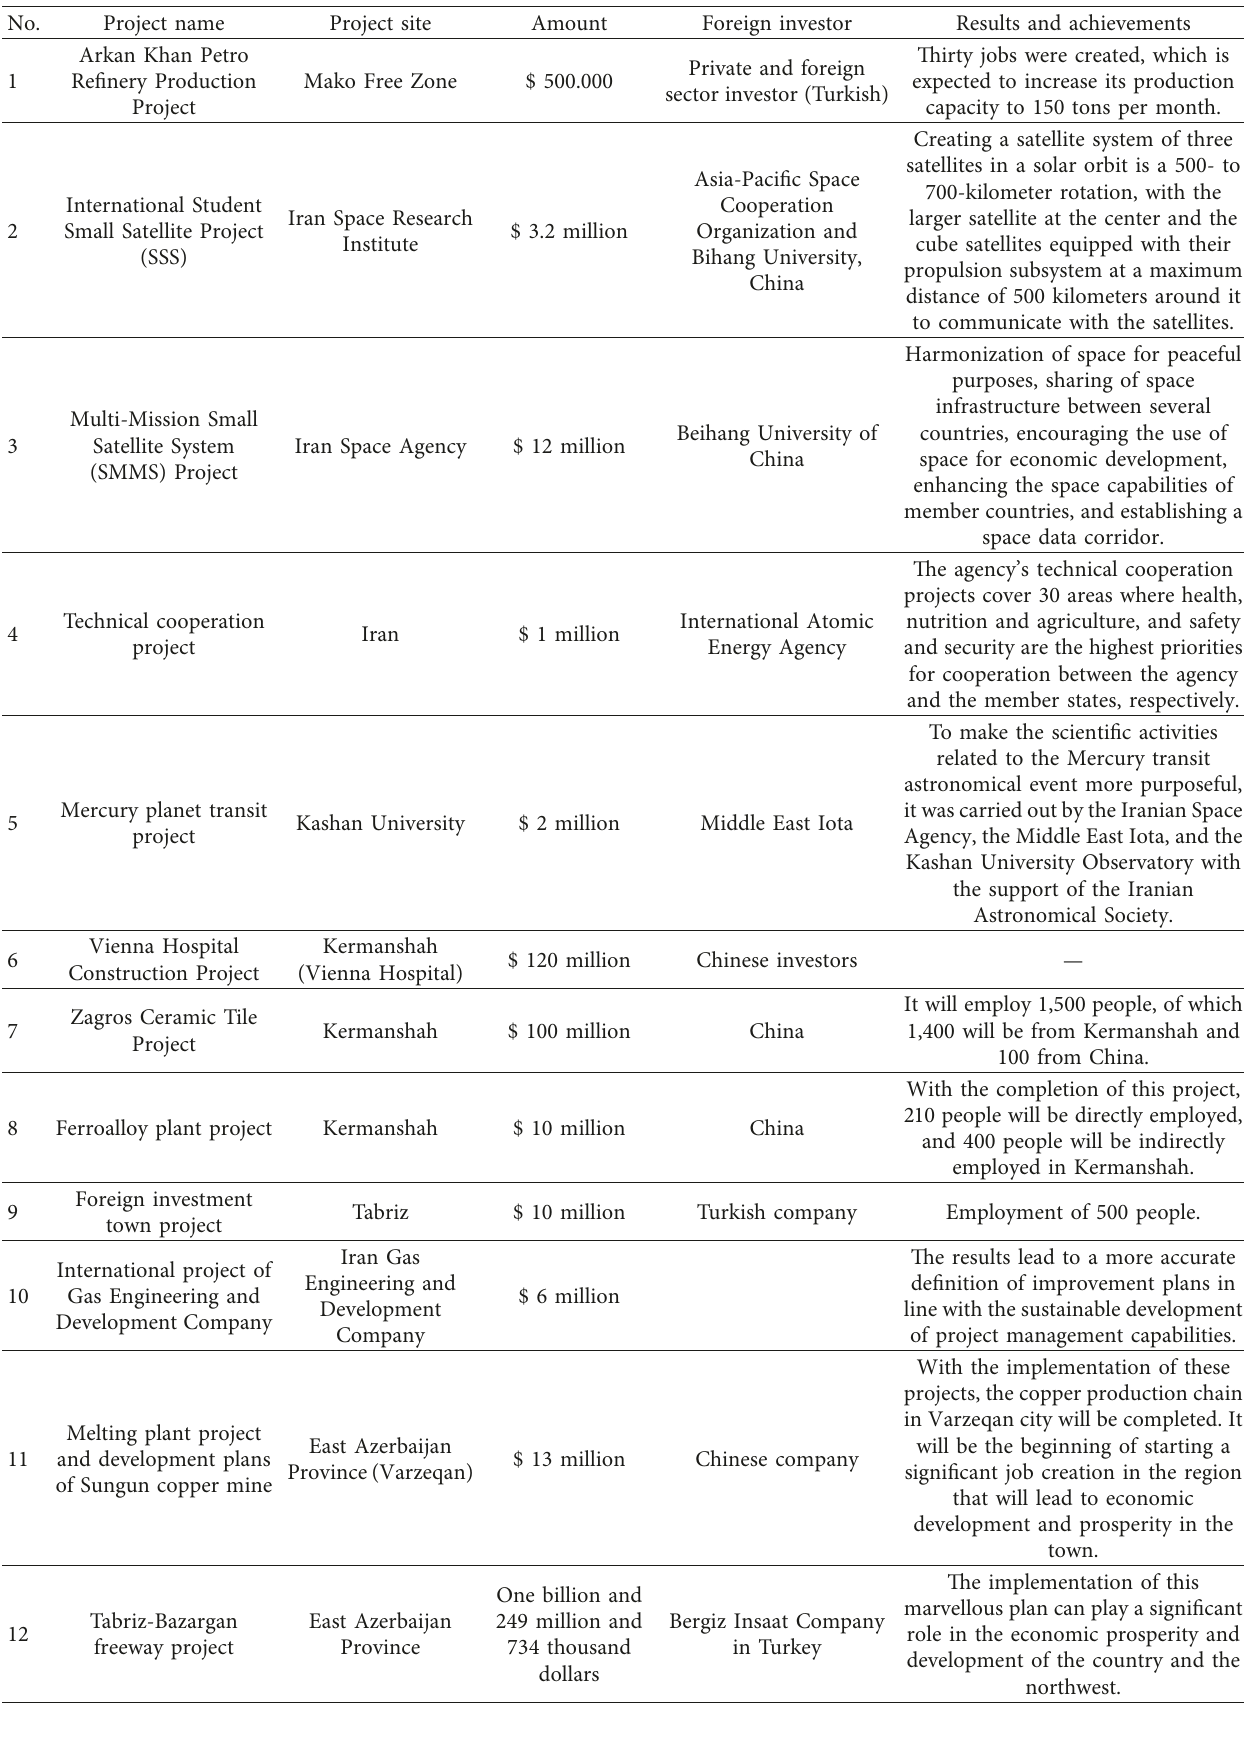
Table 4: List of international